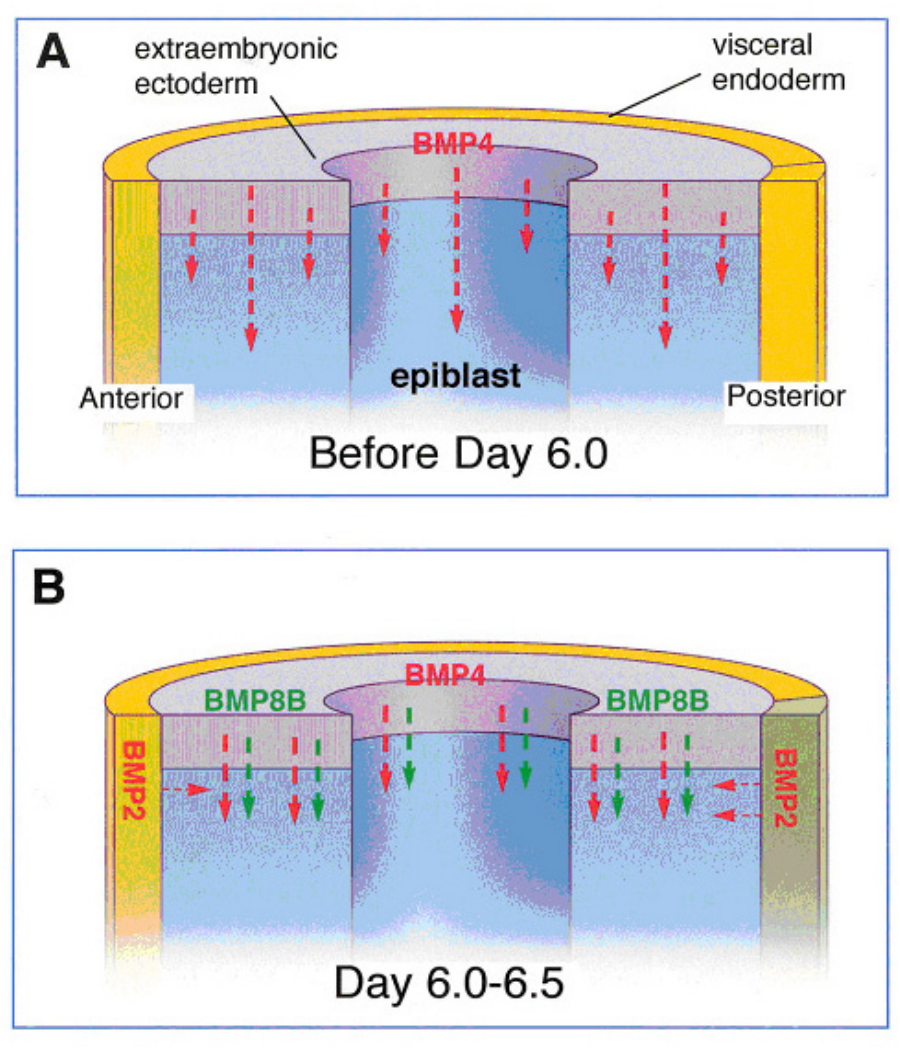
FIGURE 2. Two steps of PGC induction by multiple BMPs during mouse embryogenesis. The diagrams only show one half of the mid portion of a pregastrula embryo. (A) Before E 6.0, BMP4 produced by the extraembryonic ectoderm is required for the epiblast cells to maintain pluripotency or germ cell competency that is essential for subsequent inductions. (B) At E 6.0(cid:150)6.5, BMP4 and BMP8B homodimers directly bind to separate receptor complexes on cells within the proximal epiblast to synergistically instruct them to develop toward a germ cell fate. In addition, visceral endoderm-derived BMP2 acts in a similar way as BMP4 for germ cell induction. Visceral endoderm at the posterior region expresses higher levels of BMP2 (two small red arrows) than the anterior region (one small red arrow). BMP2 and BMP4 are indicated in red, while BMP8B is depicted in